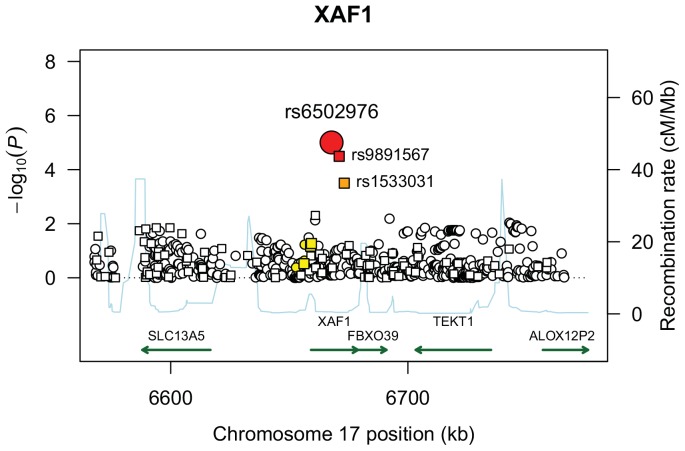
Plot of association test results across chromosome 17p13.1–13.3.The –log10 (P-values) plotted are from SNP association tests adjusted for global percent African ancestry and sex. Association p-values plotted with squares indicate genotyped SNPs; circles indicate imputed SNPs. Shading indicates linkage disequilibrium (LD) r2 values between SNP rs6502976 and the remaining SNPs in the region (strong LD: r2≥0.8 (red); moderate LD: r2≥0.5 (orange); weak LD: 0.8>r2>0.5 (yellow); not in LD: r2<0.2 (white)) were estimated in a sample of 250 unrelated African American controls from the current study. Recombination rates are displayed in blue and are based on the average across the phase II International HapMap reference populations.